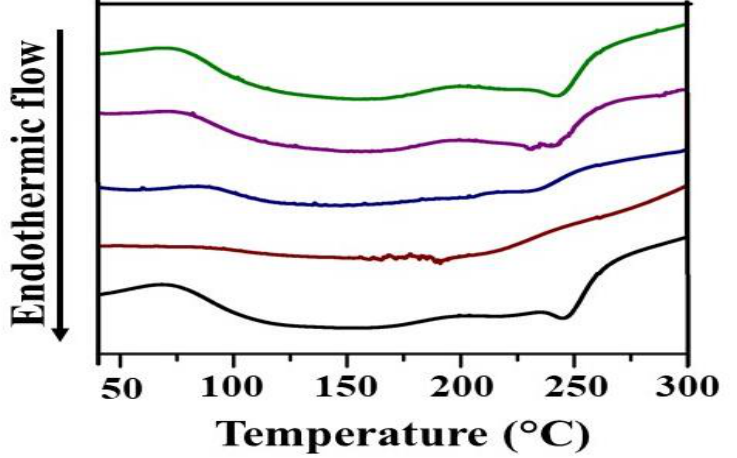
Fig. 6: DSC thermograms of pectin ( ▲ ), LS extract ( ▲ ), S8 ( ▲ ), S5 ( ▲ ), and S2 ( ▲ ) formulations.